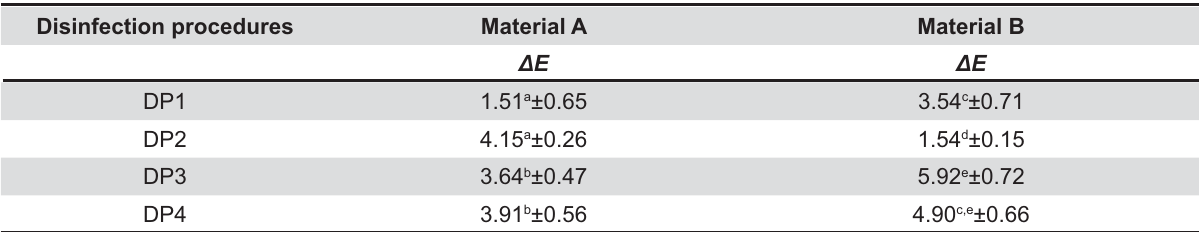
different (p>0.05). Values reported are an average of 5 specimens